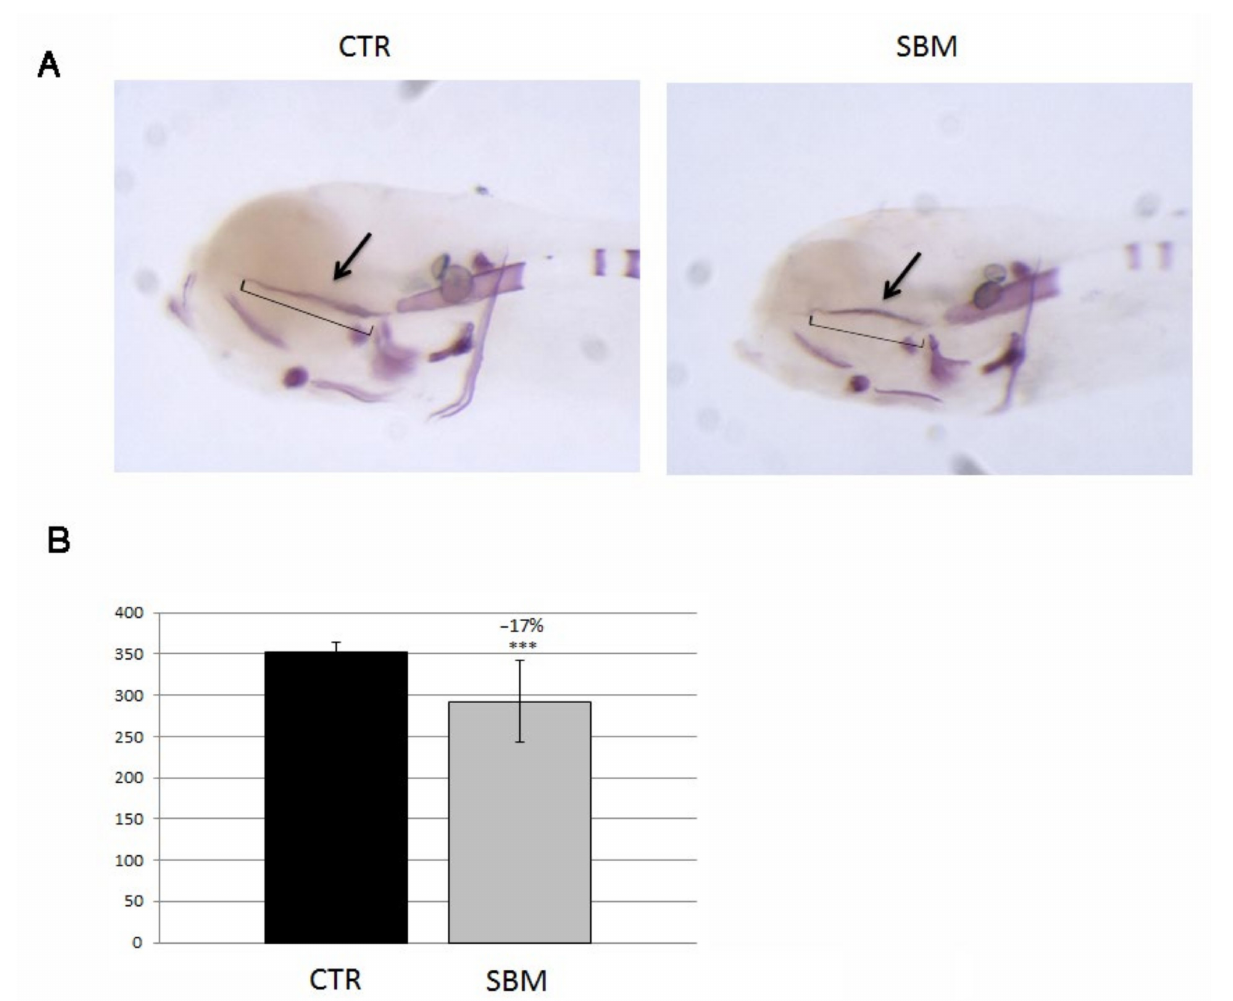
Figure 4. Later view of zebrafish larvae head stained with alizarin red. ( A ) Mineralizing structures of CTR and SBM embryos can be visualized in purple, black arrow indicates the ethmoid plate, which is formed by intramembranous mineralization. ( B ) Length of ethmoid plate (square bracket in A ), measured in CTR and SBM larvae (SBM vs. CTR, − 17%, p < 0.001). Data derived from 10 CTR and 10 SBM larvae, with tests performed 3 times as independent experiments with comparable results and significant differences were evaluated using Student’s t -test (*** p <